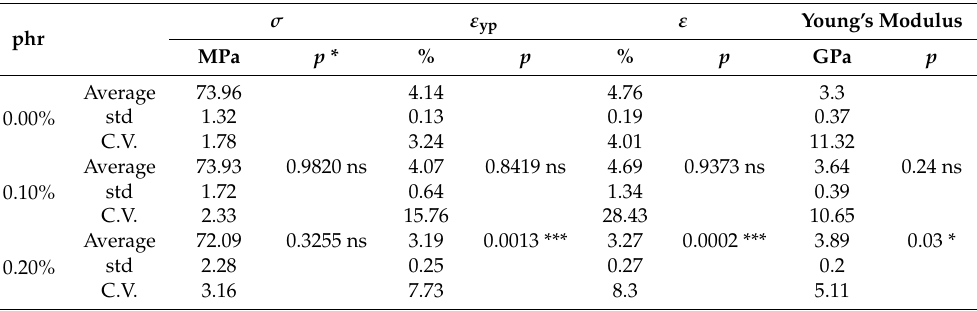
Table 2. Tensile tests data.